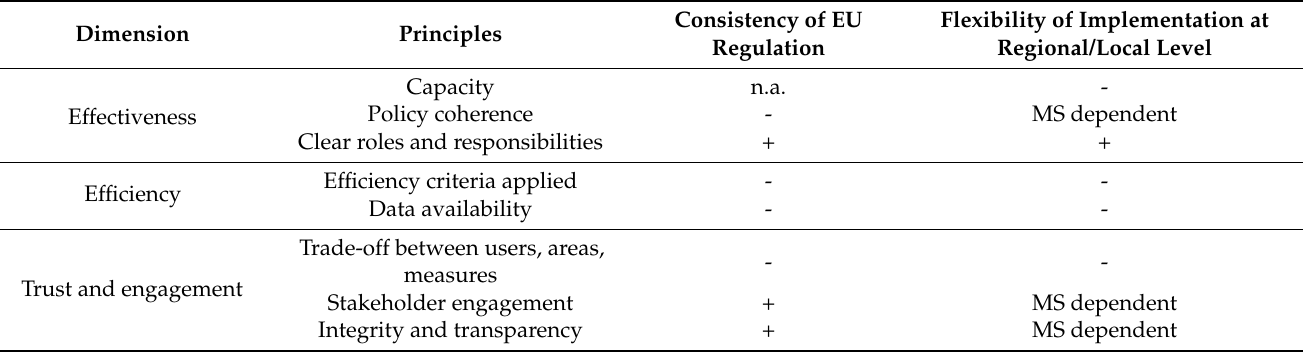
Table 3. EU rural development policy assessment